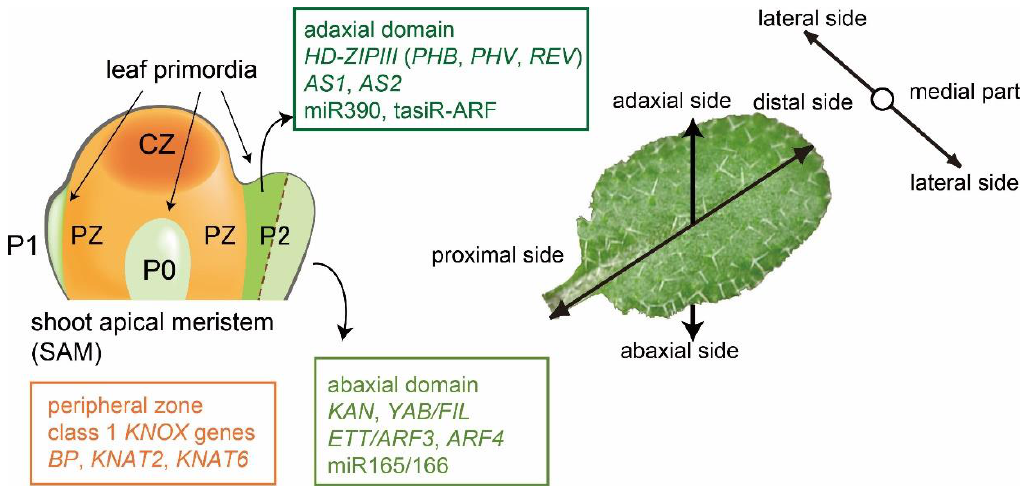
Figure 1. The leaf structure develops along three axes. Developmental compartments in the shoot apex around the apical meristem and the three structural leaf axes are schematically shown on the left and right sides, respectively (see details in text). CZ, central zone; PZ, peripheral zone; p0, primordium 0; p1, primordium 1; p2, primordium 2. Schematic representations are modified from ref. [2].